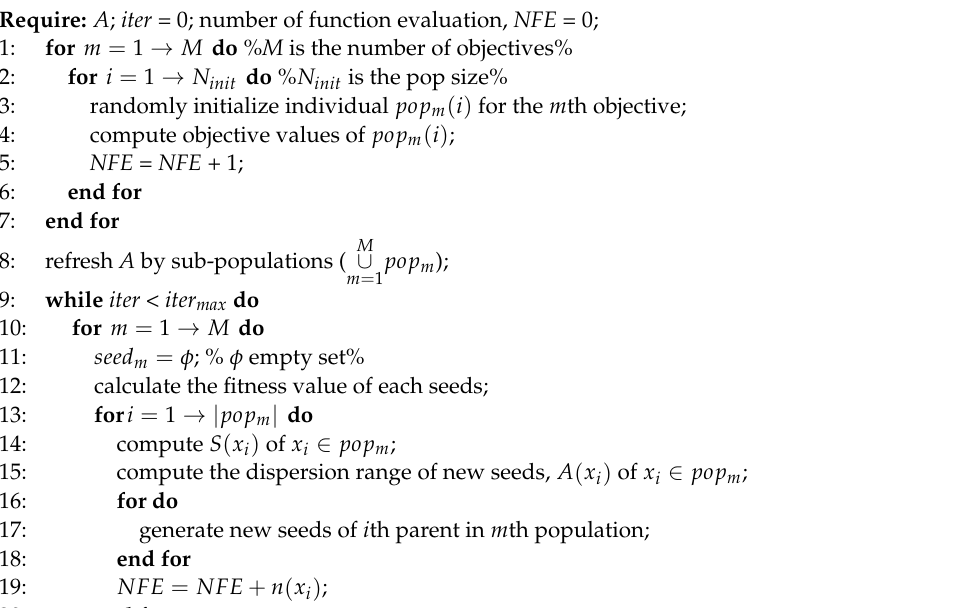
Algorithm 3. CMGBO